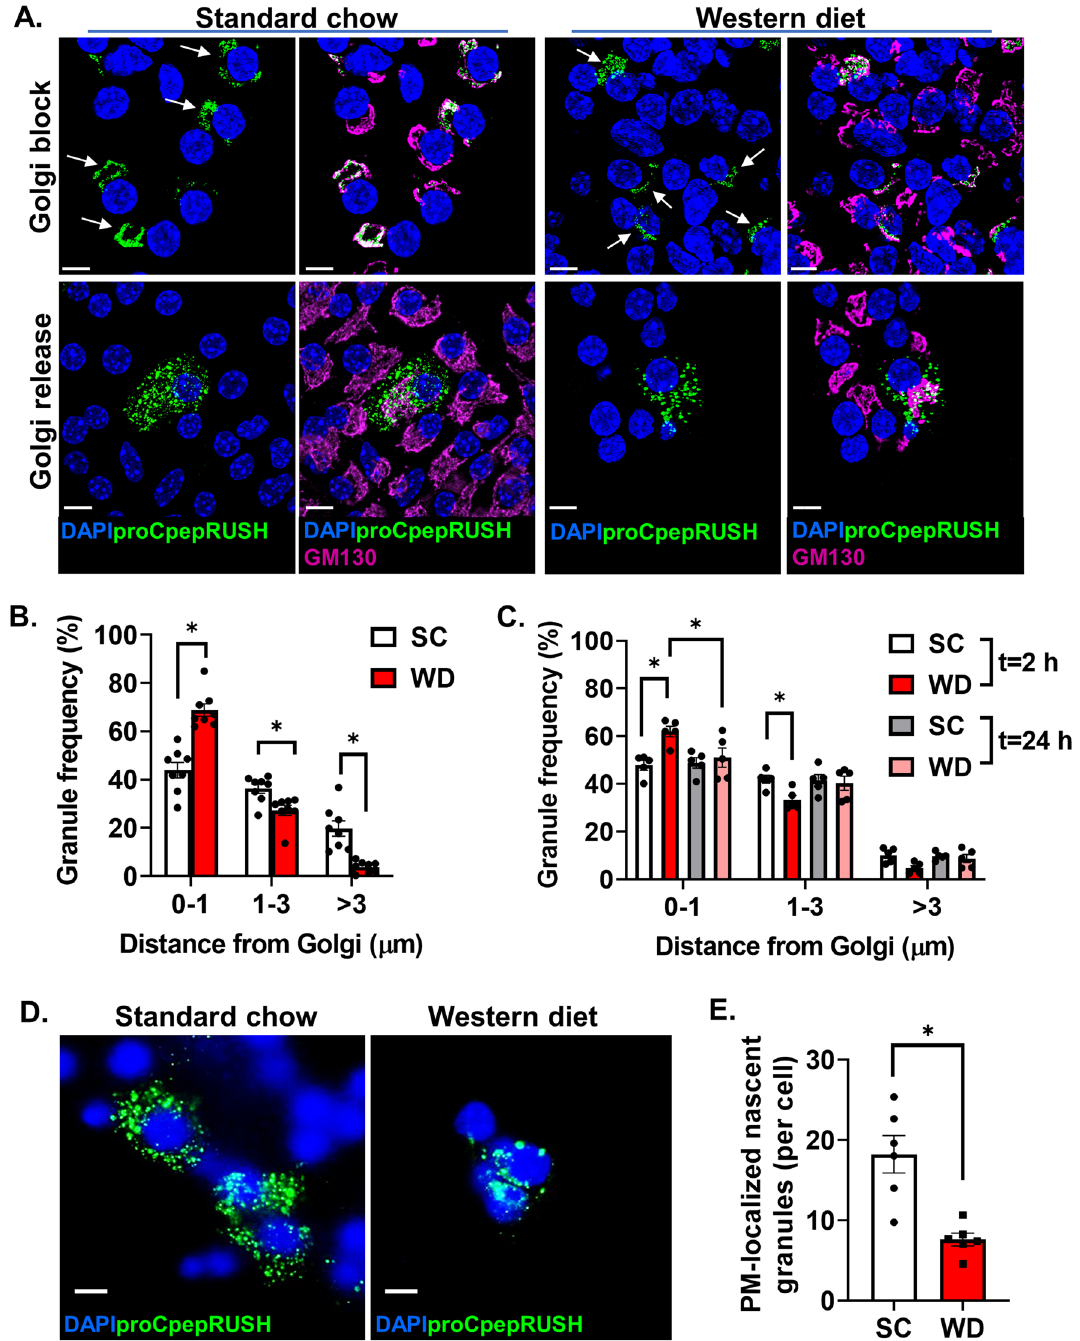
Figure 5. Impaired insulin trafficking from the Golgi in a diet-induced model of islet dysfunction. 8–10 week old male C57BL6/J mice were maintained on standard chow (SC) or Western diet (WD; 40% fat/kcal, 43% carbohydrate) for 8–10 weeks. Isolated mouse islets were treated with AdRIP-proCpepRUSH. 48 h post-infection, islets were incubated at 19 °C for 1 h and treated with biotin (200 μM) for an additional 2 h at 19 °C to initiate proCpepRUSH (green) trafficking, but block Golgi exit. Islets were then shifted to 37 °C for the indicated times to stimulate Golgi release. Cells were immunostained for GM130 (magenta) and counterstained with DAPI (blue). ( A - C ) Islets were imaged by confocal microscopy. ( A ) Representative images are shown for Golgi block (white arrows denote Golgi- localized proCpepRUSH) and Golgi release t = 2 h. ( B ) The distances of proCpepRUSH-positive granules from the Golgi (2 h post-Golgi release) were normalized as a frequency distribution per cell (n = 8 mice per group; 4–28 cells per mouse). ( C ) The distances of proCpepRUSH-positive granules from the Golgi (2 h and 24 h post-Golgi release) were normalized as a frequency distribution per cell (n = 5 mice per group; 7–18 cells per mouse). ( D, E ) Islets were imaged by TIRF microscopy following 2 h Golgi release. Representative images are shown ( D ) and the total number of plasma membrane (PM)-localized proCpepRUSH-positive granules were normalized per cell (n = 6 mice per group; 11–58 cells per mouse) ( E ). ( B , C , E ) Data represents the mean ± S.E.M. * p < 0.05 by 2 way-ANOVA with Sidak post-test analysis ( B , C ) or two-tailed unpaired Student t test ( E ). ( A , D ) Scale bar = 5